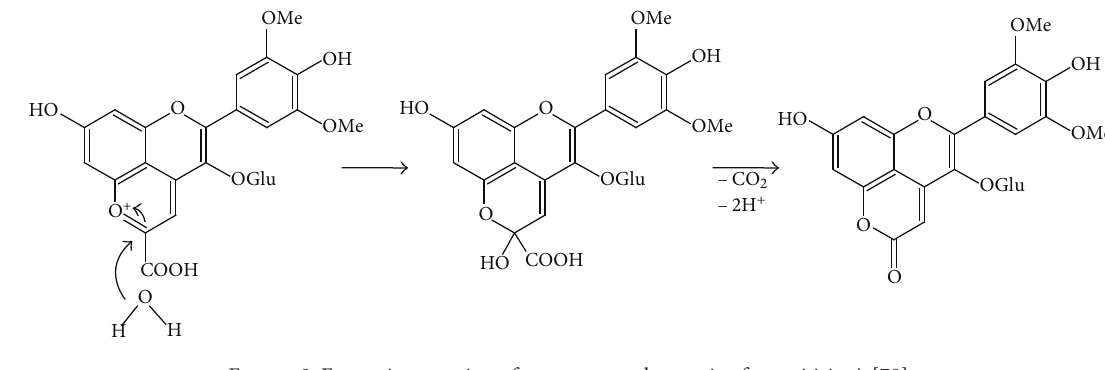
F 8: Formation reaction of pyranone-anthocyanins from vitisin A [78].